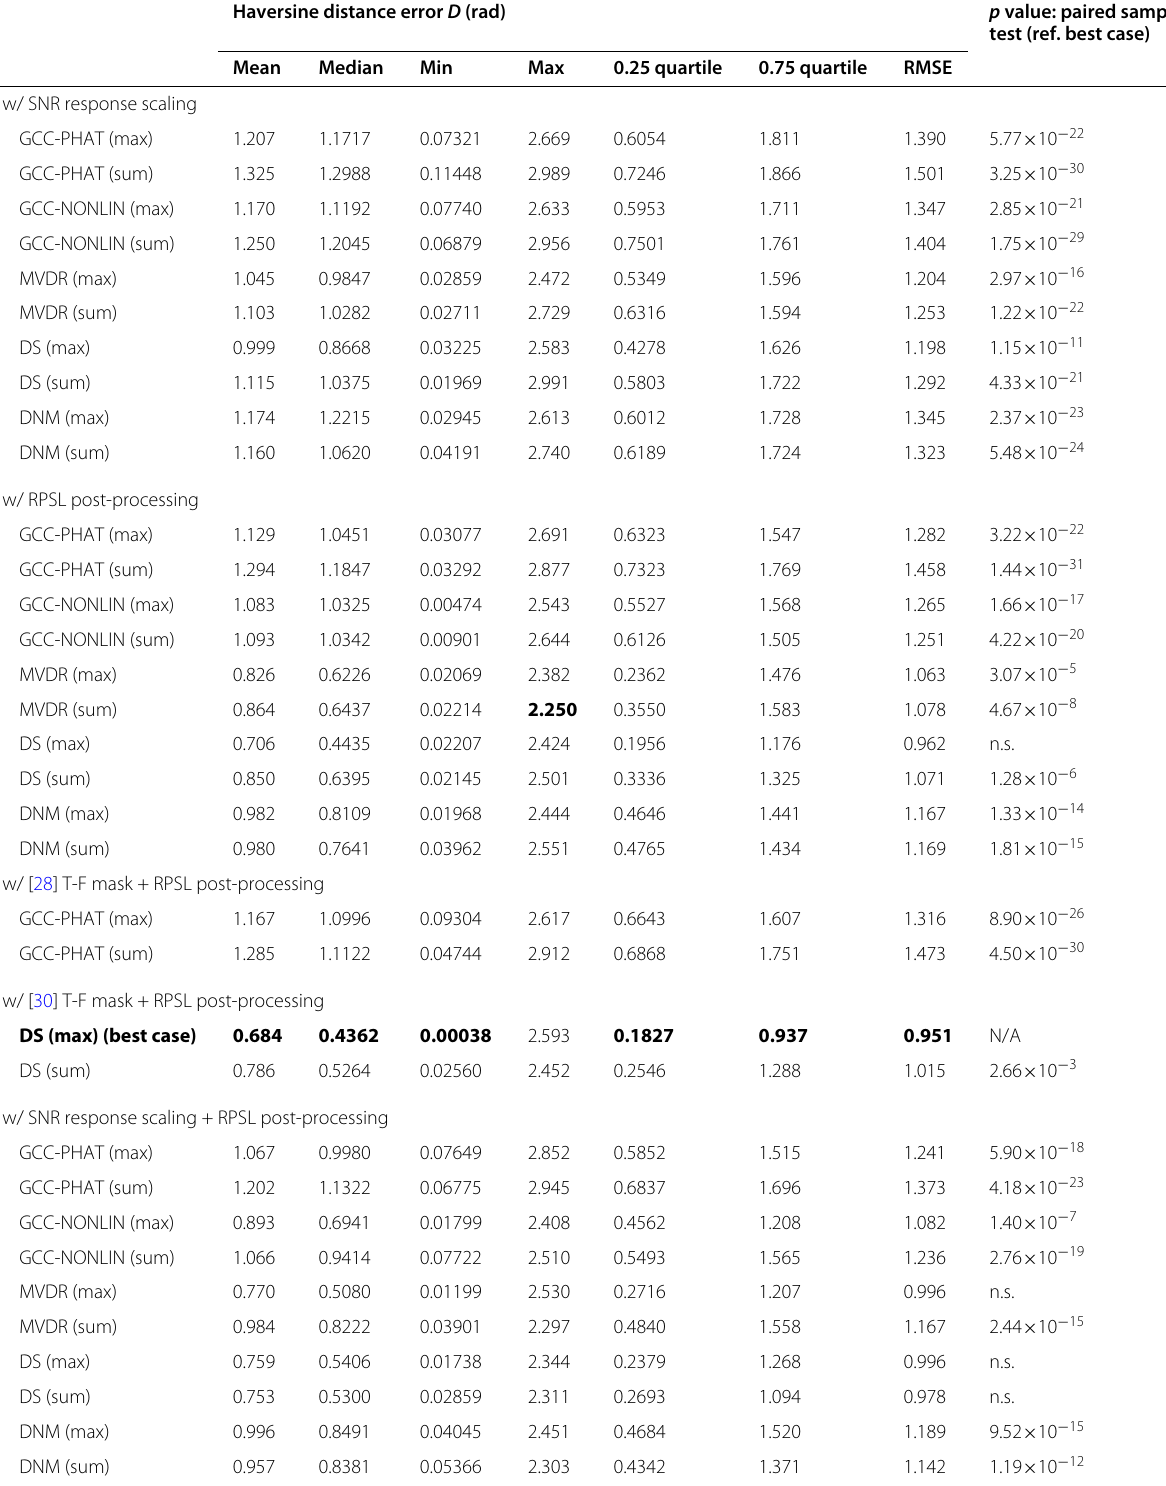
Table 5 Haversine distance error performance comparison (task 3—flying UAV, speech sound source) ( Continued ) Haversine distance error D (rad) p value: paired sample t